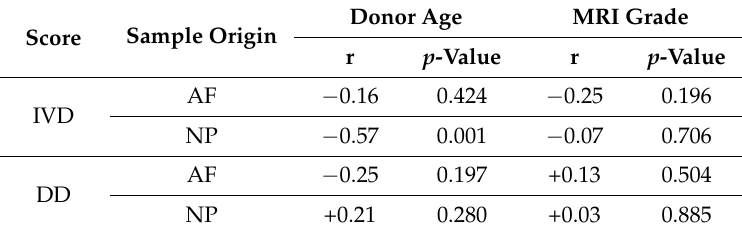
Table 4. Spearman’s correlation analysis of IVD and DD score with donor age and MRI degeneration grade. Donor Age MRI Grade Score Sample Origin